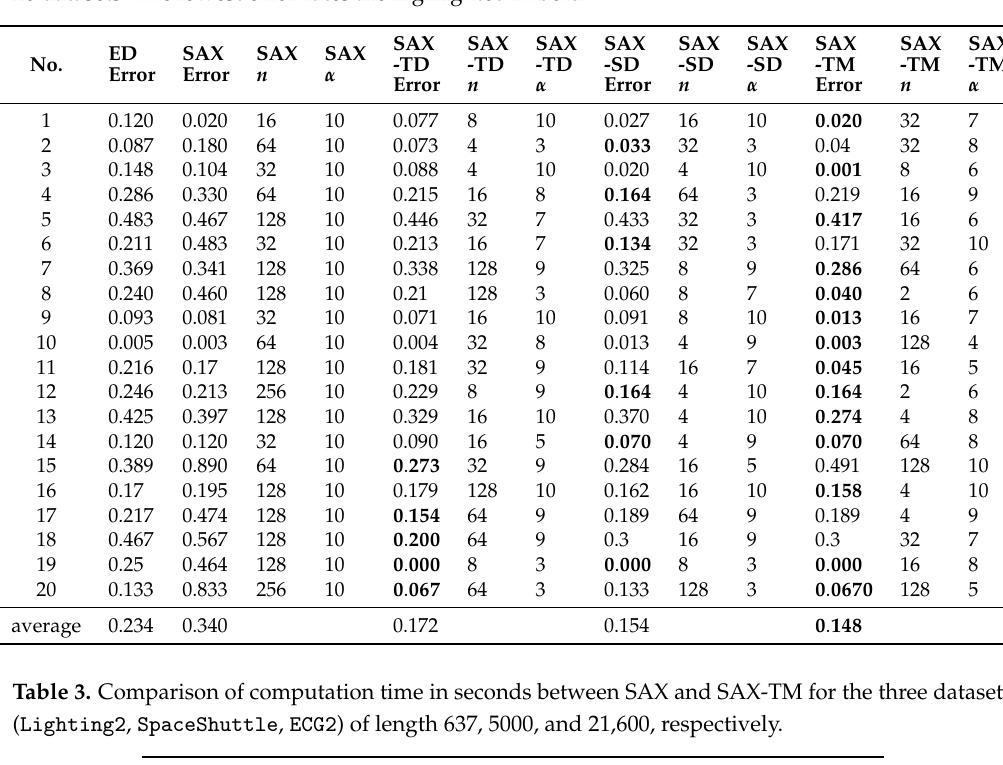
Table 2. 1NN classification error rates of ED (Euclidean distance); 1NN best classification error rates, length n , and dimensionality reduction ratio α of the SAX, SAX-TD, SAX-SD, and SAX-TM on 20 datasets. The lowest error rates are highlighted in bold.